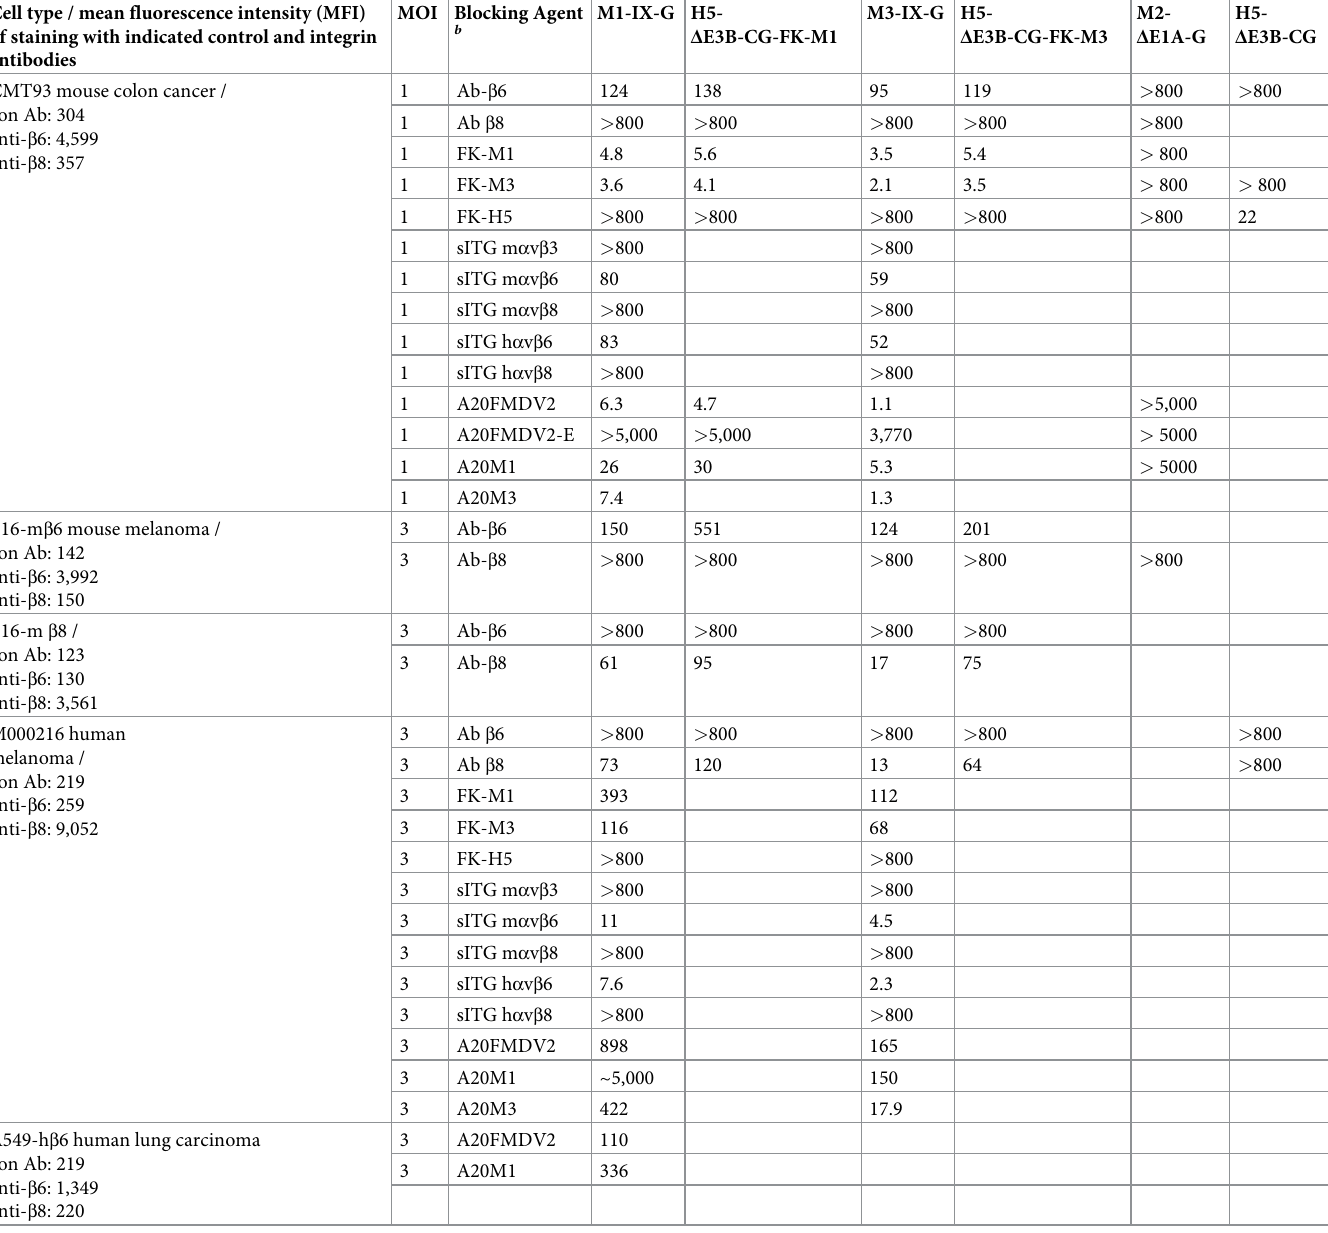
a Data correspond to blocking experiments shown in Figs 2 and 6 and S4, S8, S9 and S11, respectively. b IC 50 concentrations of antibodies, FKs and sITGs are in ng/ml; concentration of peptides are in nM